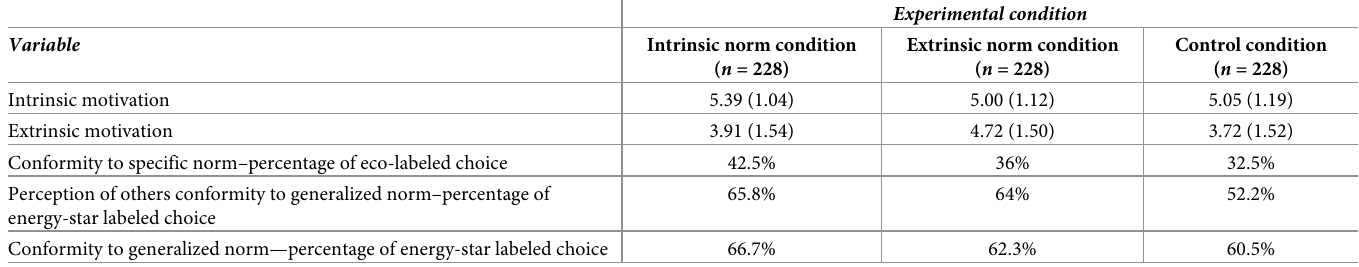
Table 1. Descriptive summary M (SD) of manipulation checks and dependent variables by experimental conditions.